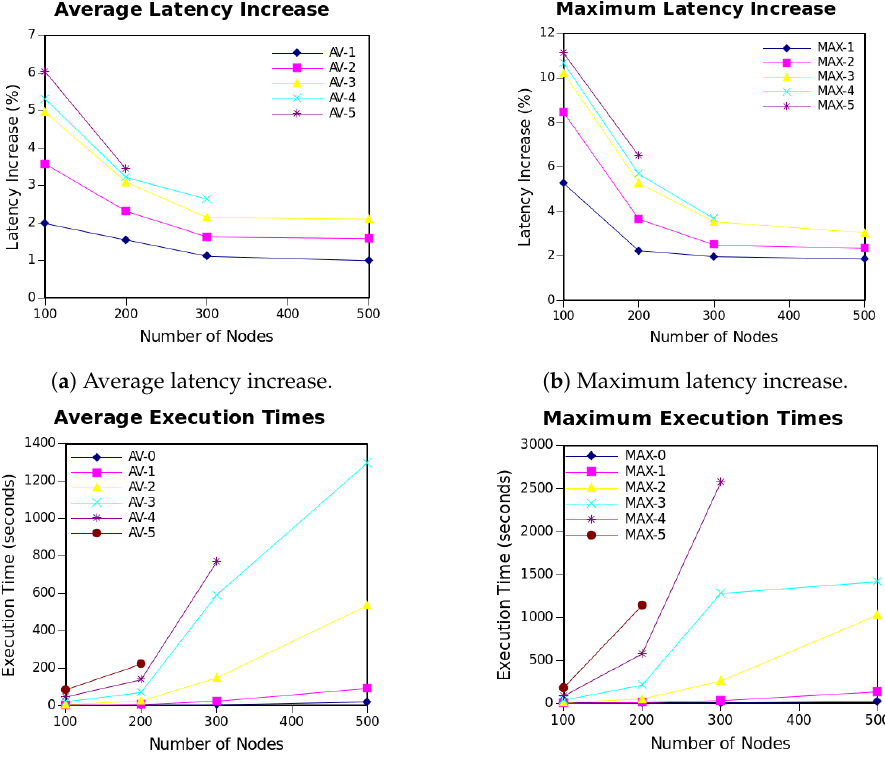
Figure 3. Average and maximum latency increase values and execution times for networks with nodes distributed in a 200 m radius